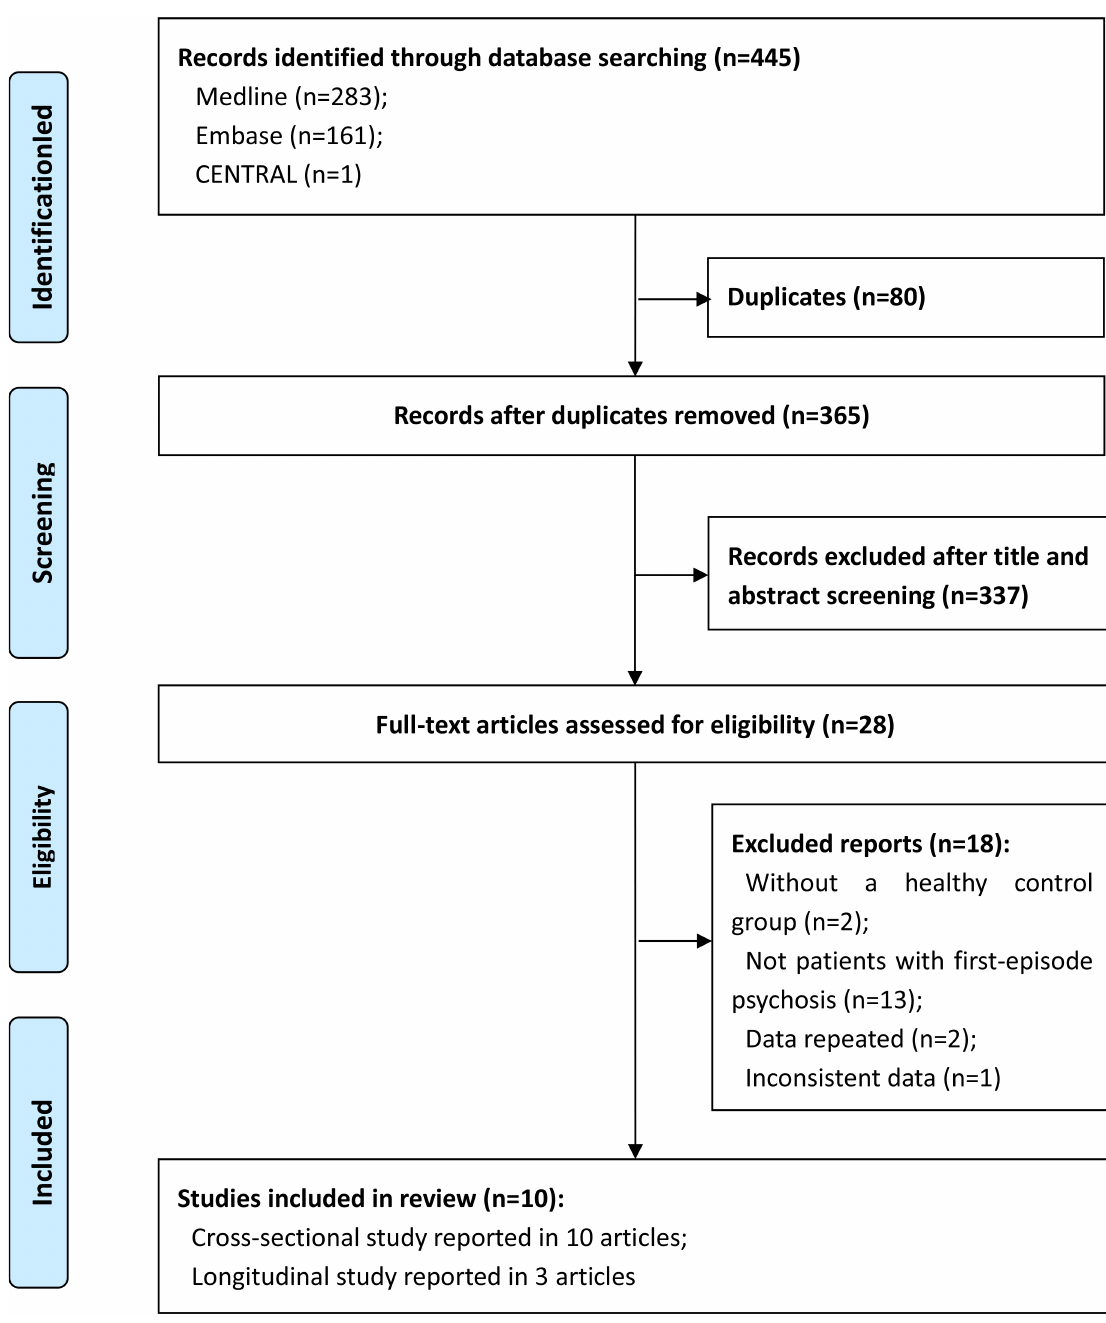
Fig 1. Article selection flow